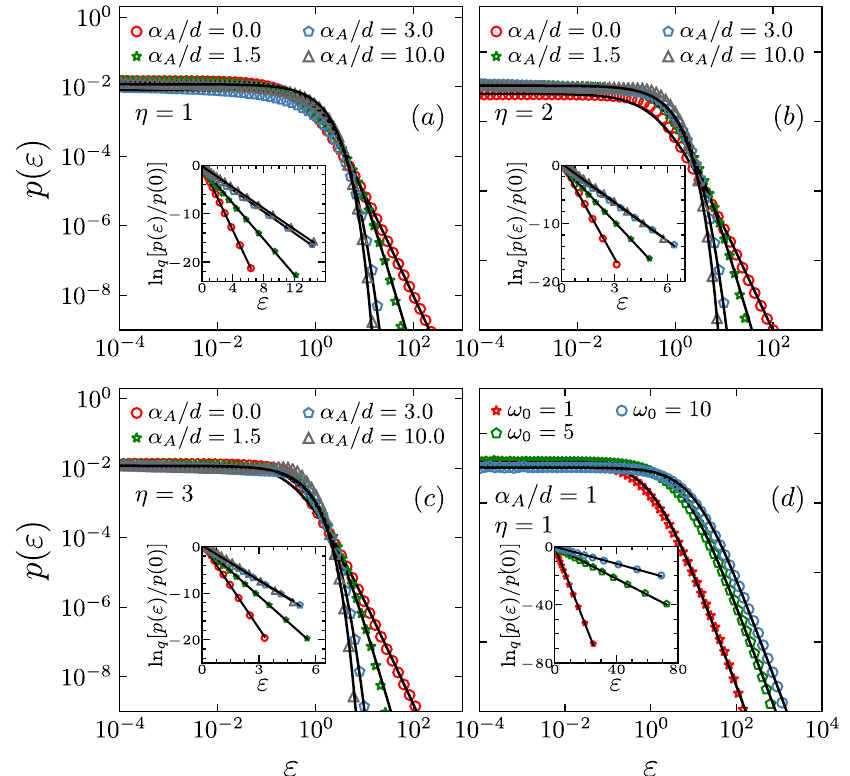
Figure 3. In these plots we show the variations of p (ε) for fixed values η = 1 ( a ) , η = 2 ( b ) and η = 3 ( c ), for α A / d = 0, 1.5, 3, 10 . In ( d ) we show the variations of p (ε) for fixed values of (α A / d , η) = ( 1, 1 ) and w 0 = 1, 5, 10 . In all figures, the black continuous lines are given by Eq. (4) with ( q , β q ) given by Eqs. (5, 6) respectively. Insets: ln q -linear representation of the same data; the slopes of the straight lines precisely yield the corresponding values of ( − β q ). The simulations were averaged over 10 3 realisations for N = 10 5